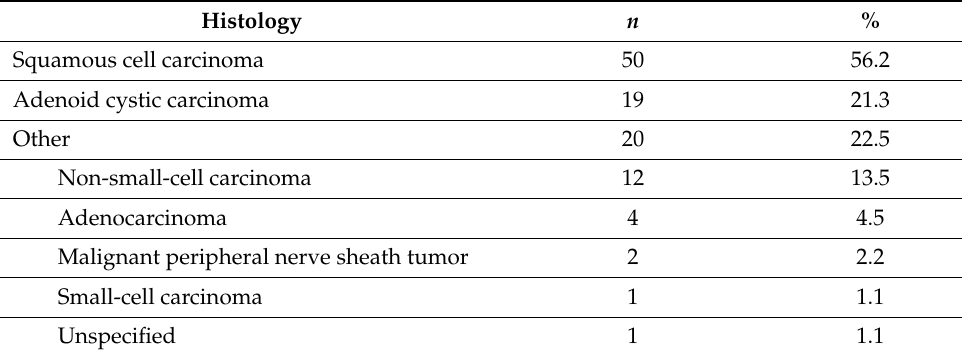
Table 2. Histological distribution of 89 tracheal cancers.